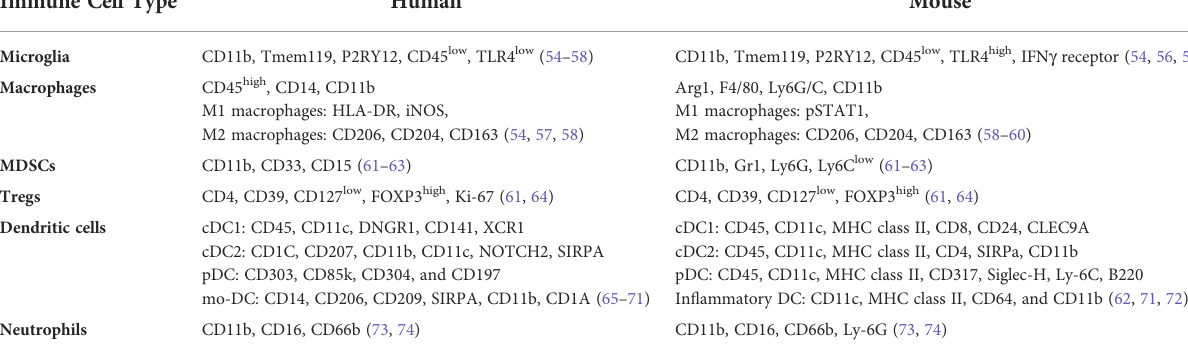
TABLE 1 Non-exhaustive list of markers expressed by GBM-associated immune